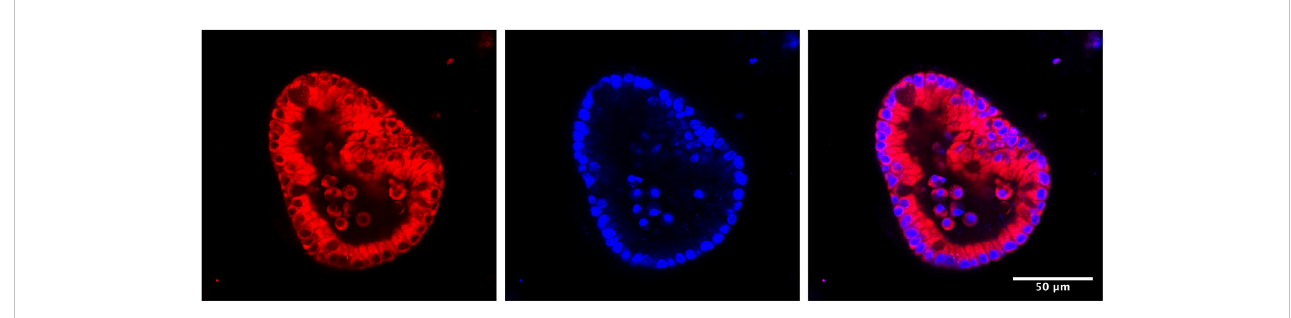
FIGURE 3 Establishmentofmouse 3-Denteroidcultureto monitorLIPinlive enteroids.1 – 2 cmofmouse duodenum isisolated,washed andcut intosmall pieces. CryptcellsareseparatedfromothertissuefragmentsthroughEDTAincubationandcentrifugation.Next,cryptcellsaremixedwithMatrigelandthenplatedon a 24-well plate. In the following days, the open crypts will close to form spherical enteroids. Stem cells in enteroids will keep proliferating when they are in enteroidculturemedia(withWntandothergrowthfactors).Ifgrowingindifferentiationmedia(withoutWntinthemedia),stemcellswilldifferentiateinto different types of intestinal cells, such as enterocytes, goblet cells, etc. To observe LIP in living enteroids under different conditions, e.g., normal condition or ferroportinisblockedbyminihepcidin,enteroidsareisolatedfromMatrigelandtreatedwithFerroOrange,a fl uorescentprobeforlabileiron.Afterhalfanhour, LIP can be observed under fl uorescent confocal